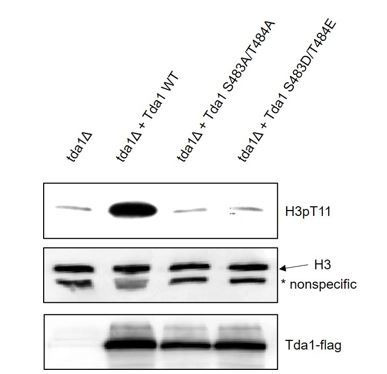
H3pT11 levels of Tda1 WT, Tda1 S483A/T484A, and Tda1 S483D/T484E mutant expressing strains analyzed by western blot.Cells were taken from overnight saturated media.